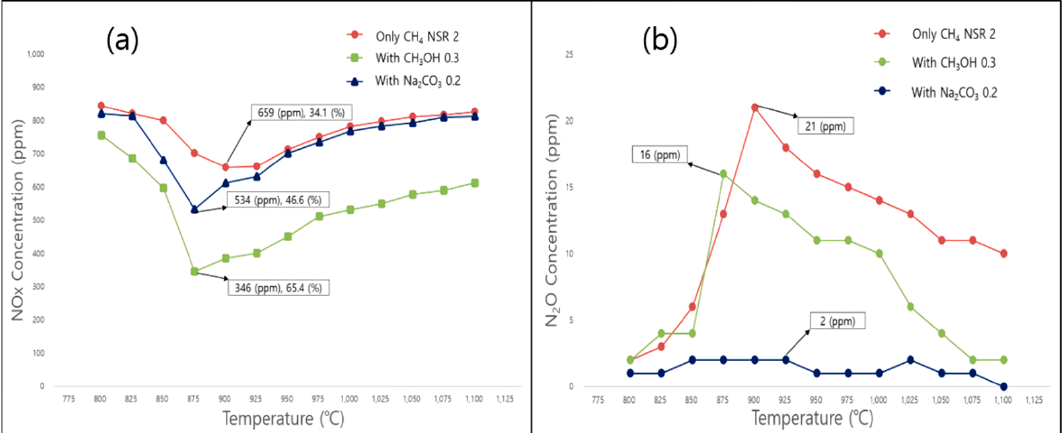
Figure 4. Effects of additives and temperature on ( a ) NO x removal and ( b ) N 2 O formation for CH 4 as the reducing agent under optimal conditions (NO = 900 ppm, NO 2 = 100 ppm, O 2 = 7 vol%, CH 4 NSR = 2.0, CH 3 OH/CH 4 = 0.3, Na 2 CO 3 /CH 4 = 0.2).